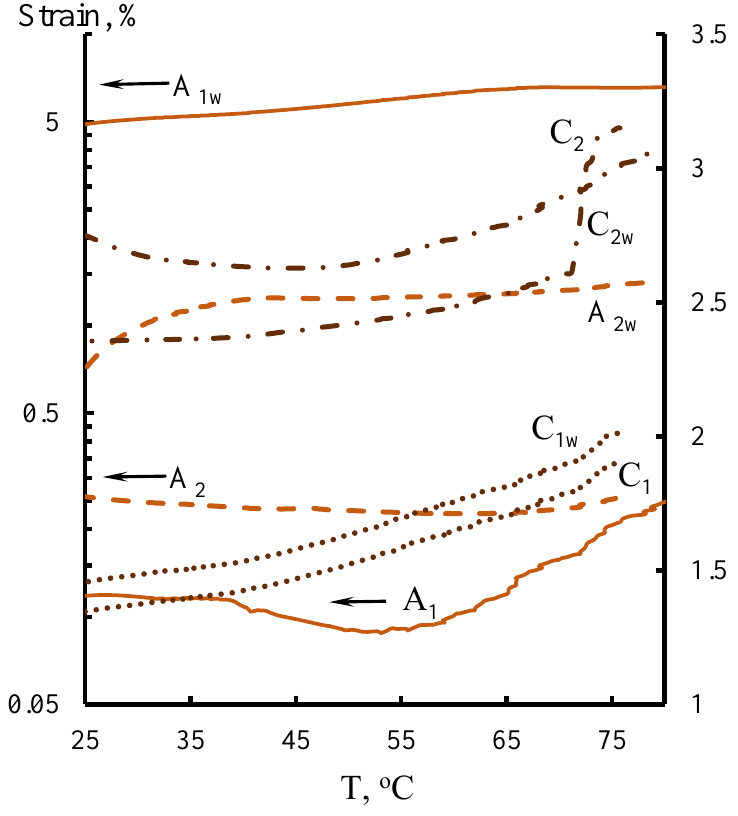
Figure 8. Temperature dependence of deformation for dry and wet (w) anion-exchange = A; cation- exchange = C. Membrane fragments at a constant tensile load of 1.5 N.